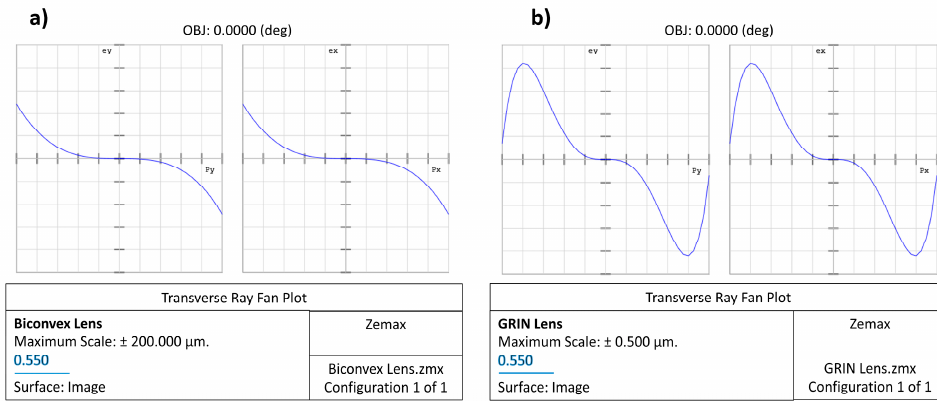
Figure 8. Ray fan plot for ( a ) biconvex lens; ( b ) GRIN lens.